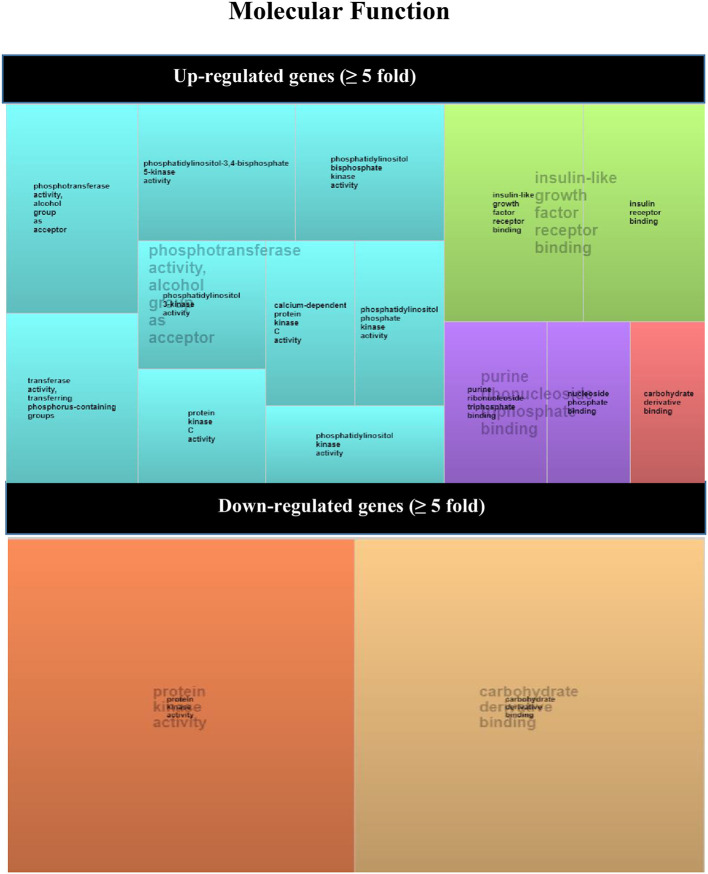
REVIGO TreeMap view of GO terms enriched between up- (upper TreeMaps) or down-regulated (lower TreeMaps) genes in biopsies from +DSA/+AMR patients vs. control recipients (–DSA/–AMR, +DSA/–AMR, and –DSA). Each rectangle is a single cluster representative. The representatives are joined into “superclusters” of loosely related terms that are visualized with distinct colors (indicated by centralized black text). The size of the rectangles reflects the enrichment of the GO term.